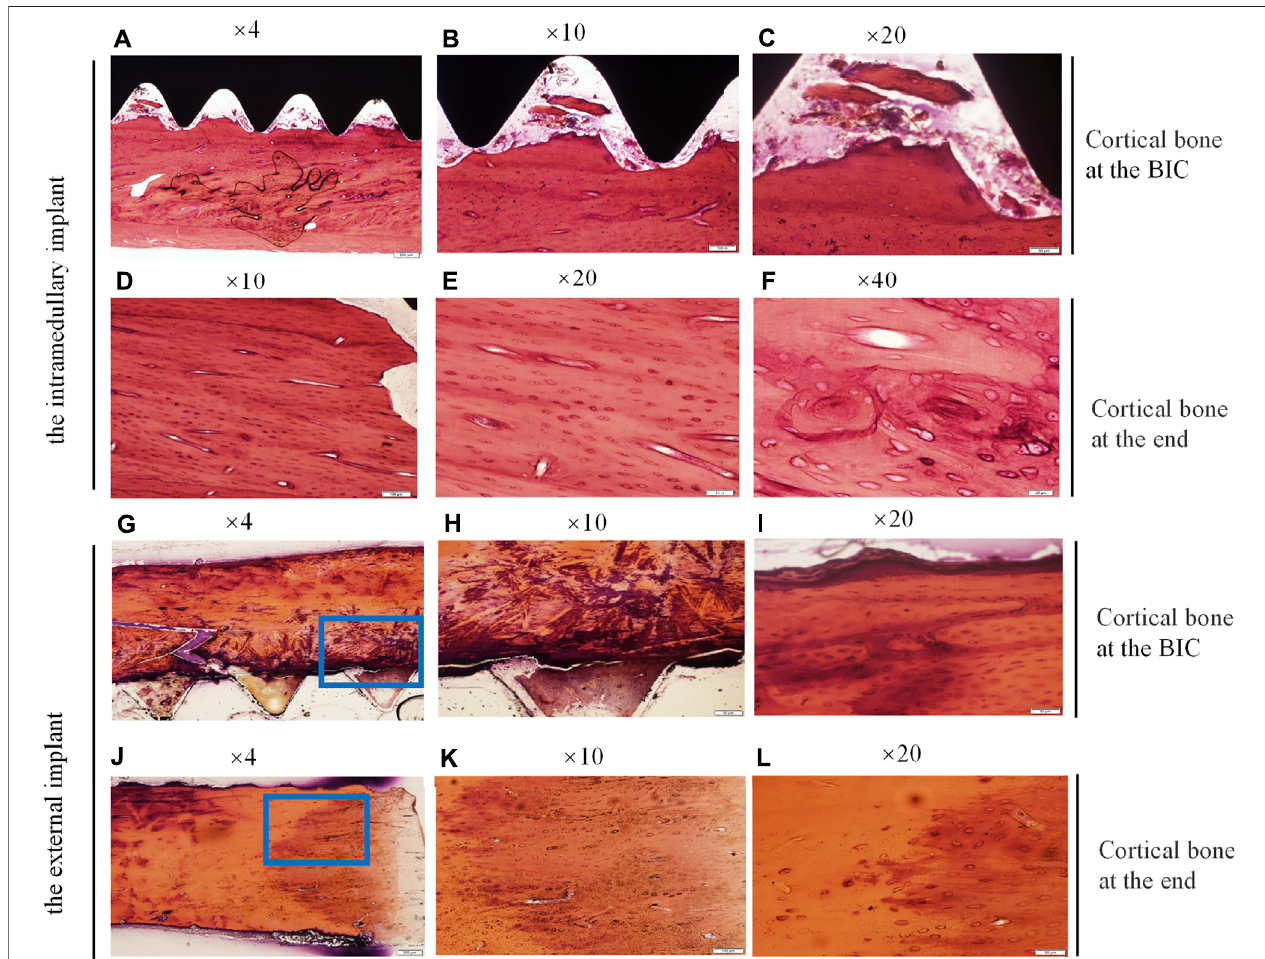
FIGURE6| HistologicalsectionsandHEstainingoftheundecalci fi edbonesamplesaroundtheimplants,observedusingahistologicalmicroscope.(magni fi cation ×10, ×20, ×40). (A – C,G – I) New bone formation within the threads of both implants at the BIC; (D – F,J – L) the cortical bone at the end of the stump. Osteocyte lacunae was